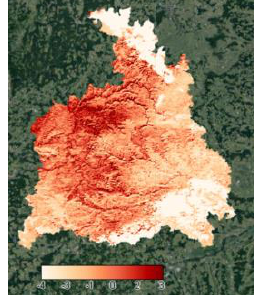
Figure 9: LST Stuttgart - Winter.